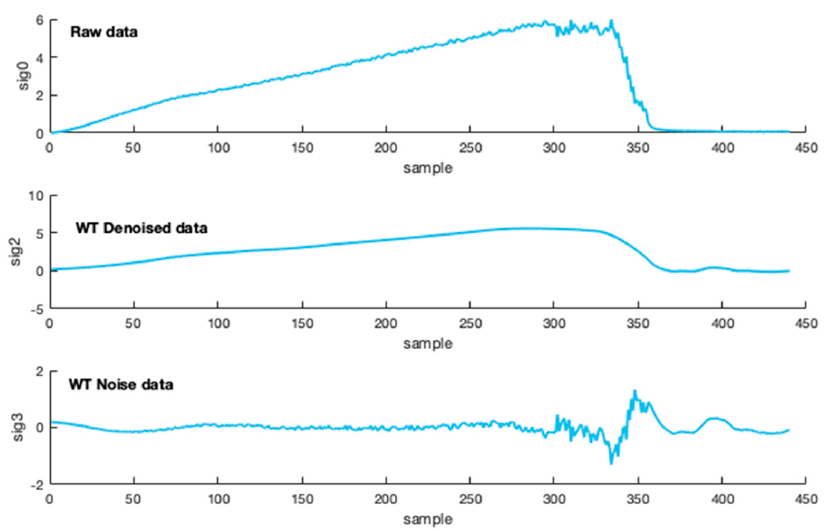
Figure 8. EWT noise reduction of “Yangdong Line.”